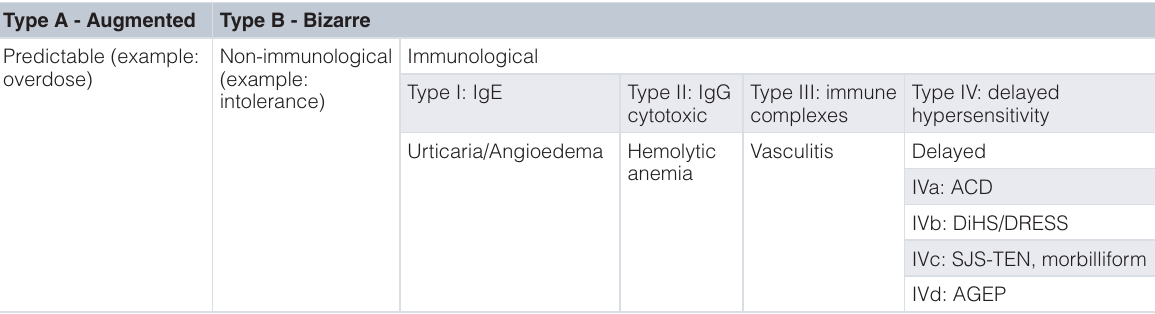
Table 1. Cutaneous adverse drug reactions mechanisms summary.